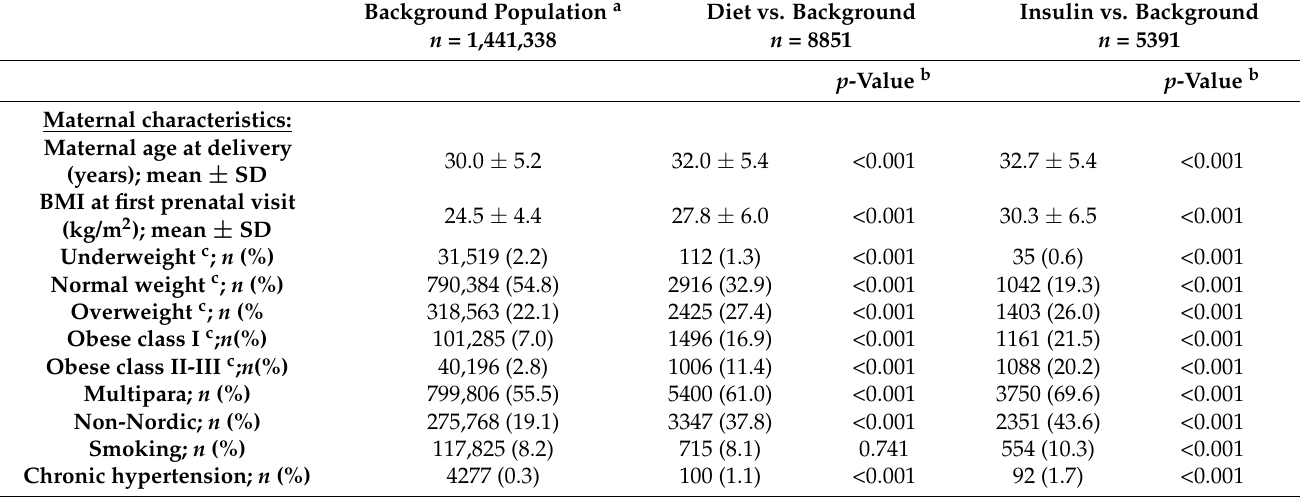
Table 1. Maternal and neonatal characteristics among singleton pregnancies diagnosed with diet- or insulin-treated